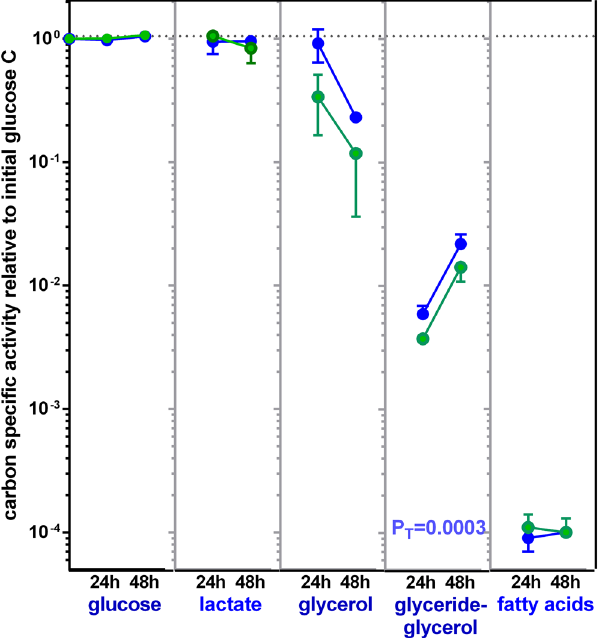
Figure 2. Carbon specific radioactivity of the main label fractions obtained after incubation of epididymal adipocytes in a primary culture in the presence of 14 C-glucose. The data are presented as mean ± sem of four different rats, and are presented in a log scale to show the wide differences between fractions. C-specific radioactivity correspond to the quotient of label found in the fraction divided by the molar concentration and the number of carbons the compound contains. In this case, all data have been referred to initial glucose C-specific radioactivity, to which a value of 1 (i.e. 10 0 ) was given. Blue dots and lines: incubation in 7 mM glucose; green dots and lines: 14 mM glucose. The statistical significance data and conventions are the same as in Figure